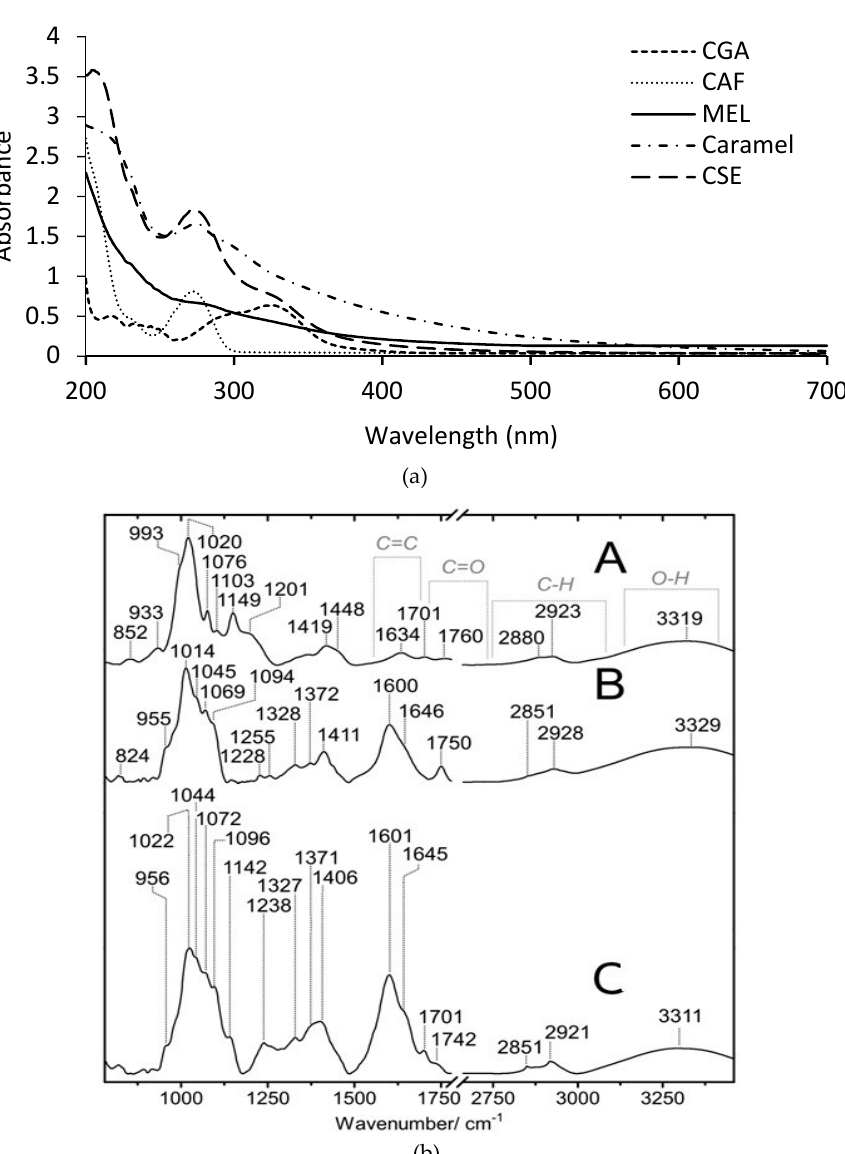
Figure 1. ( a ) UV-VIS spectra of caramel, melanoidins (MEL), coffee silverskin extract (CSE), caffeine (CAF), and chlorogenic acid (CGA). ( b ) IR spectra of caramel (A), coffee silverskin extract (B), and melanoidins (C). Relevant bands and vibrational modes are indicated.